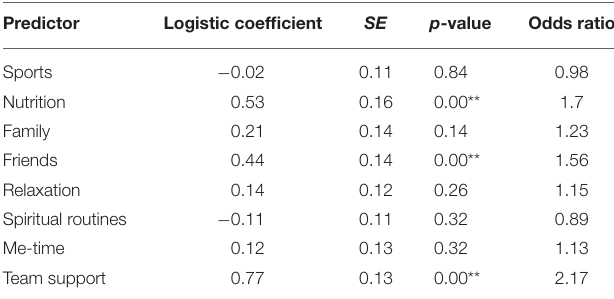
TABLE 2 | Use of self-care strategies and job satisfaction—results of logistic ordinal regression model. Predictor Logistic coefficient